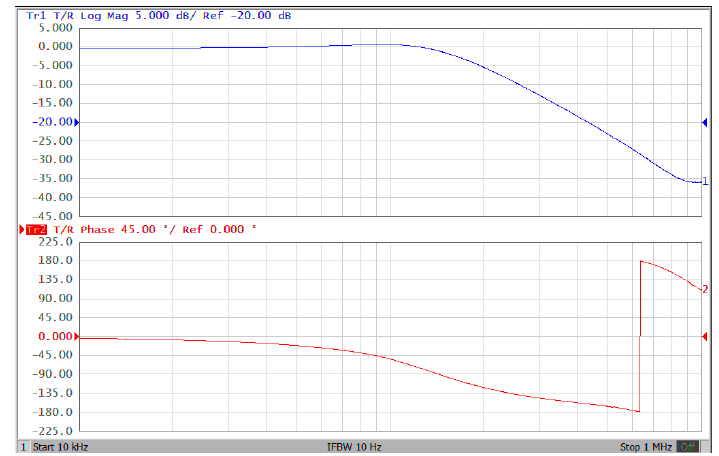
Figure 34. Experimentally observed gain and phase responses of the LP filter realized in case II.